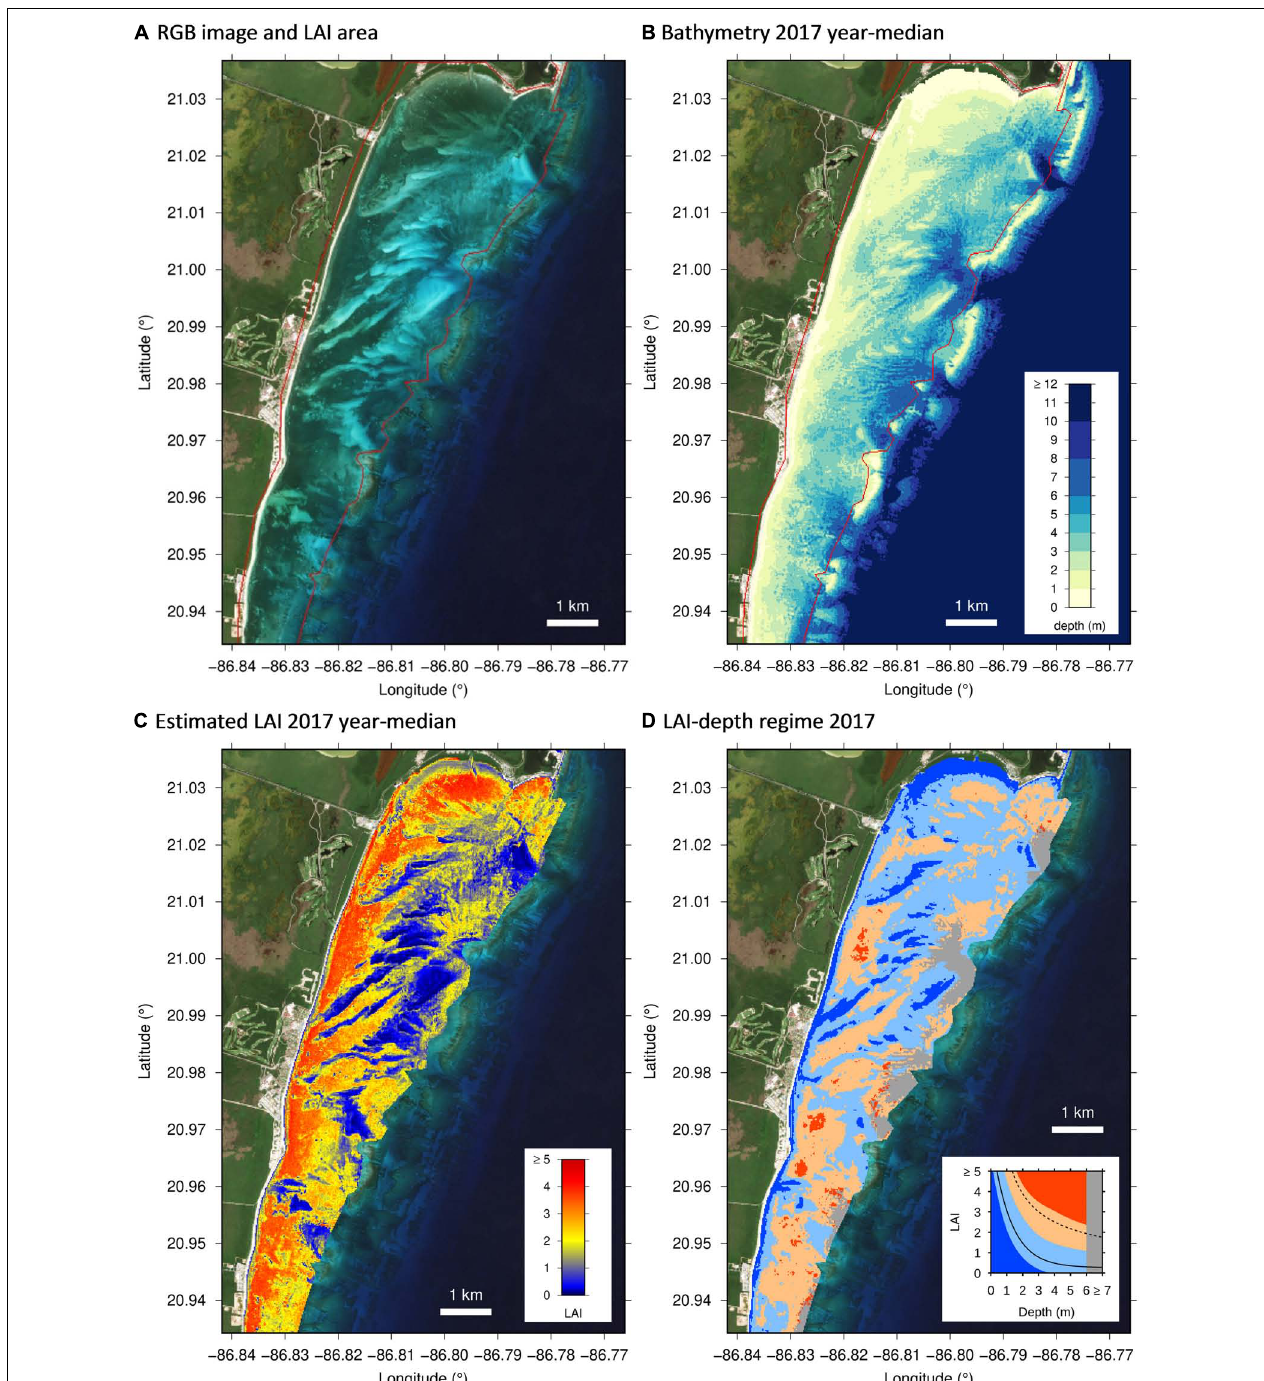
FIGURE 4 | Example results from the northern part of the Puerto Morelos lagoon. (A) RGB image from 13 December 2017, (B) 2017 year-median depth, (C) 2017 year-median estimated LAI, (D) LAI-depth regime for 2017 based on (B,C) . Red line in (A,B) is the limit of the LAI area of interest.